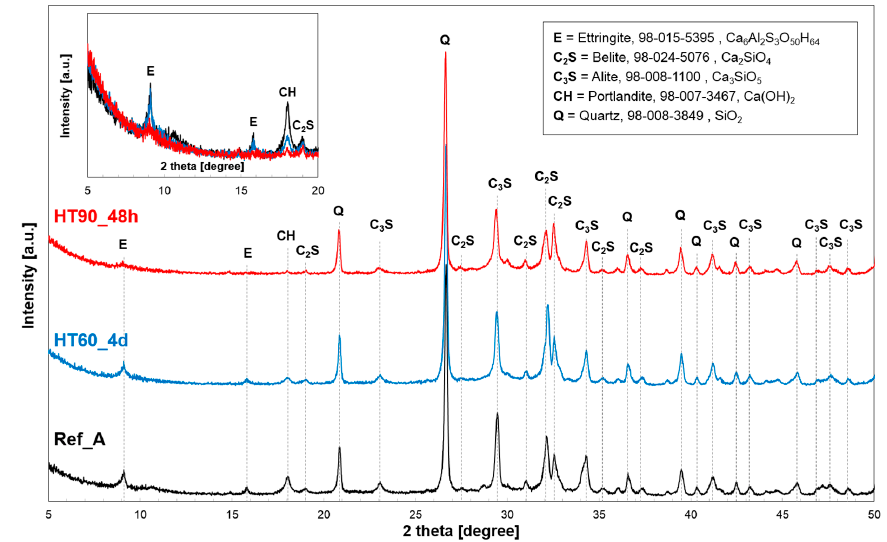
Figure 5. XRD patterns of UHPC at 28 days: E = ettringite, C 2 S = belite, C 3 S = alite, CH = portlandite, Q =